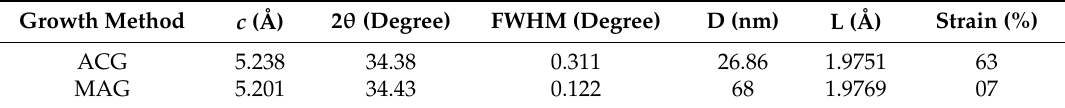
Table 2. Structural parameters of samples grown with ACG and MAG growth methods. Full width